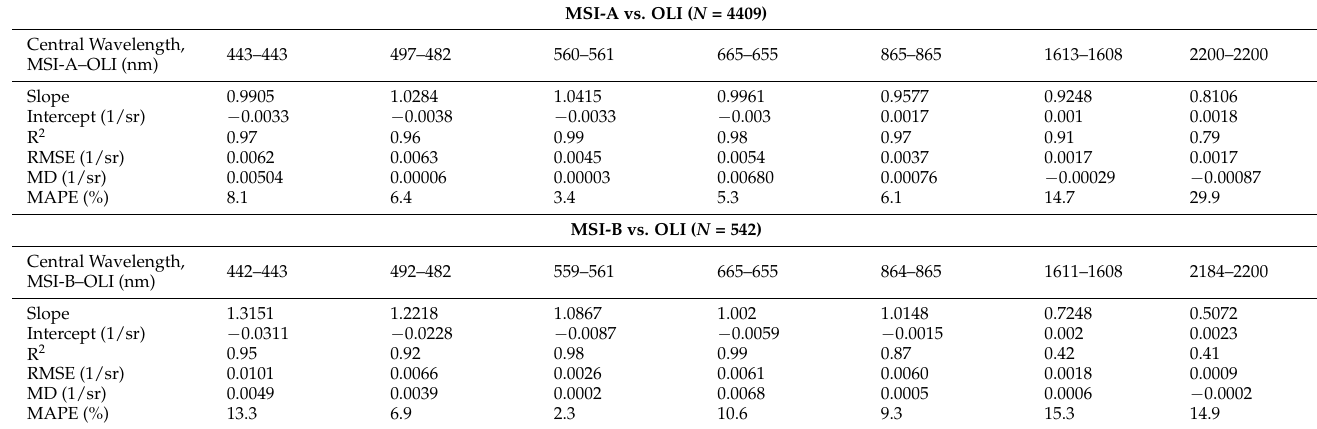
Table 4. Inter-comparison of ρ rc after vicarious calibration.